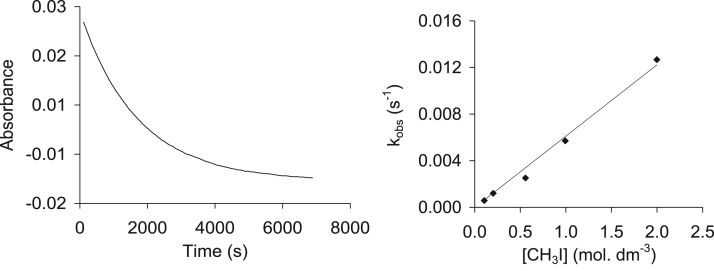
Left: the absorbance vs time graph measuring the decrease in vibration height (2085 cm−1) vs time was used to determine kobs. Right: the methyl iodide concentration dependence of the oxidative addition reaction between CH3I and Rh(H3CCOCHCOCH3)CO(C6H5OPPh2), (4), as monitored by FTIR.